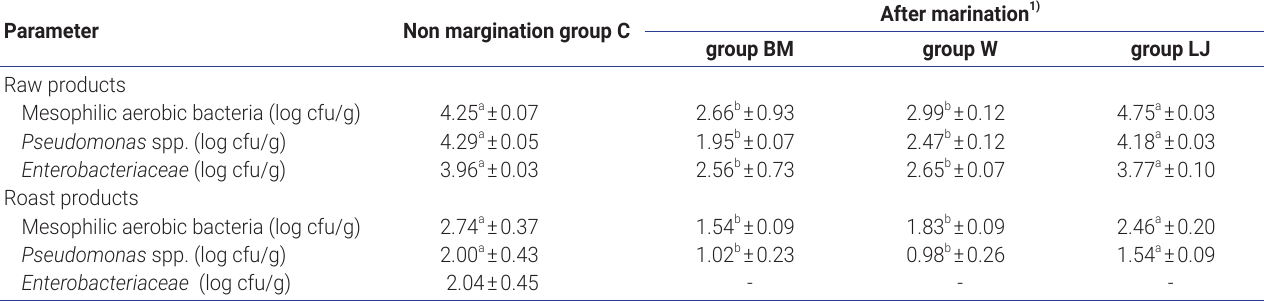
Table 2. The effect of marinating on microbiological parameters of raw and roasted products Parameter